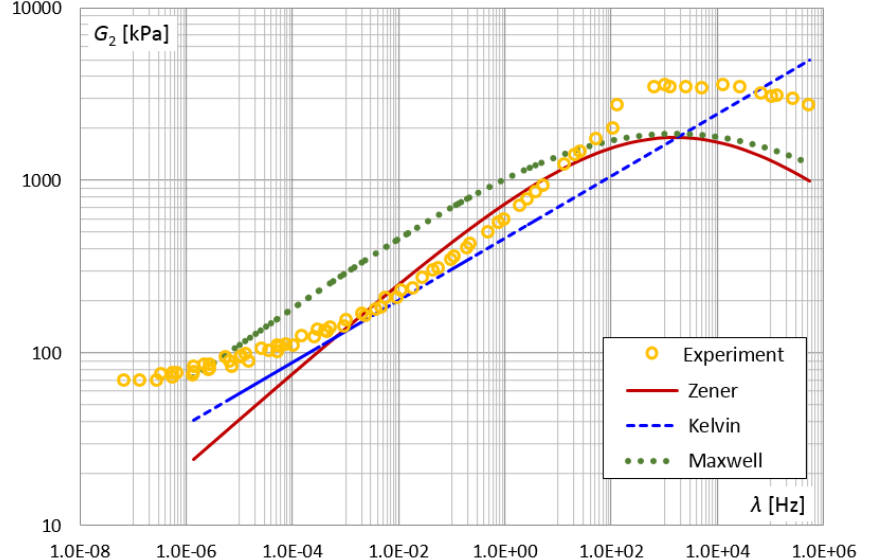
Figure 29. The shear loss modulus G 2 vs. frequency for different fractional